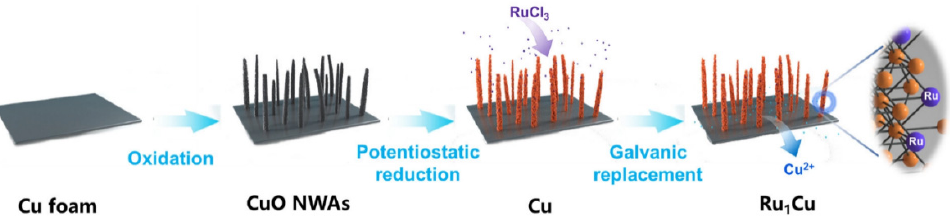
Figure 9. Schematic illustration of synthetic route for Ru 1 Cu single atom alloys. Reproduced with permission from ref [87]. Copyright 2022 Wiley-VCH.